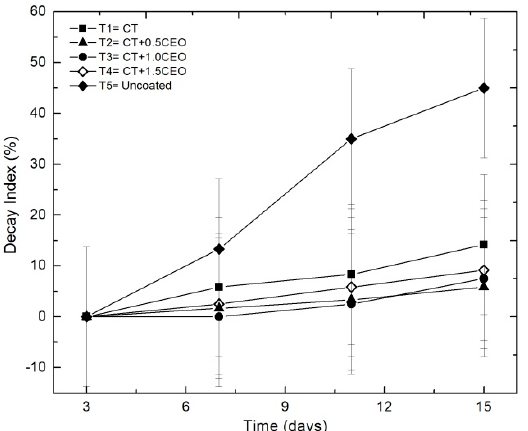
Figure 7. Evolution of the decay index in strawberries with chitosan (CT) and treatments of oil (TCEO): T1 = CT, T2 = CT + 0.5% of TCEO, T3 = CT + 1.0% of TCEO, T4 = CT + 1.5% TCEO, and T5 = uncoated under cold storage. Mean values and intervals of Fisher’s LSD of 95% according to the ANOVA test. Data were transformed using the logarithmic function prior to analysis.